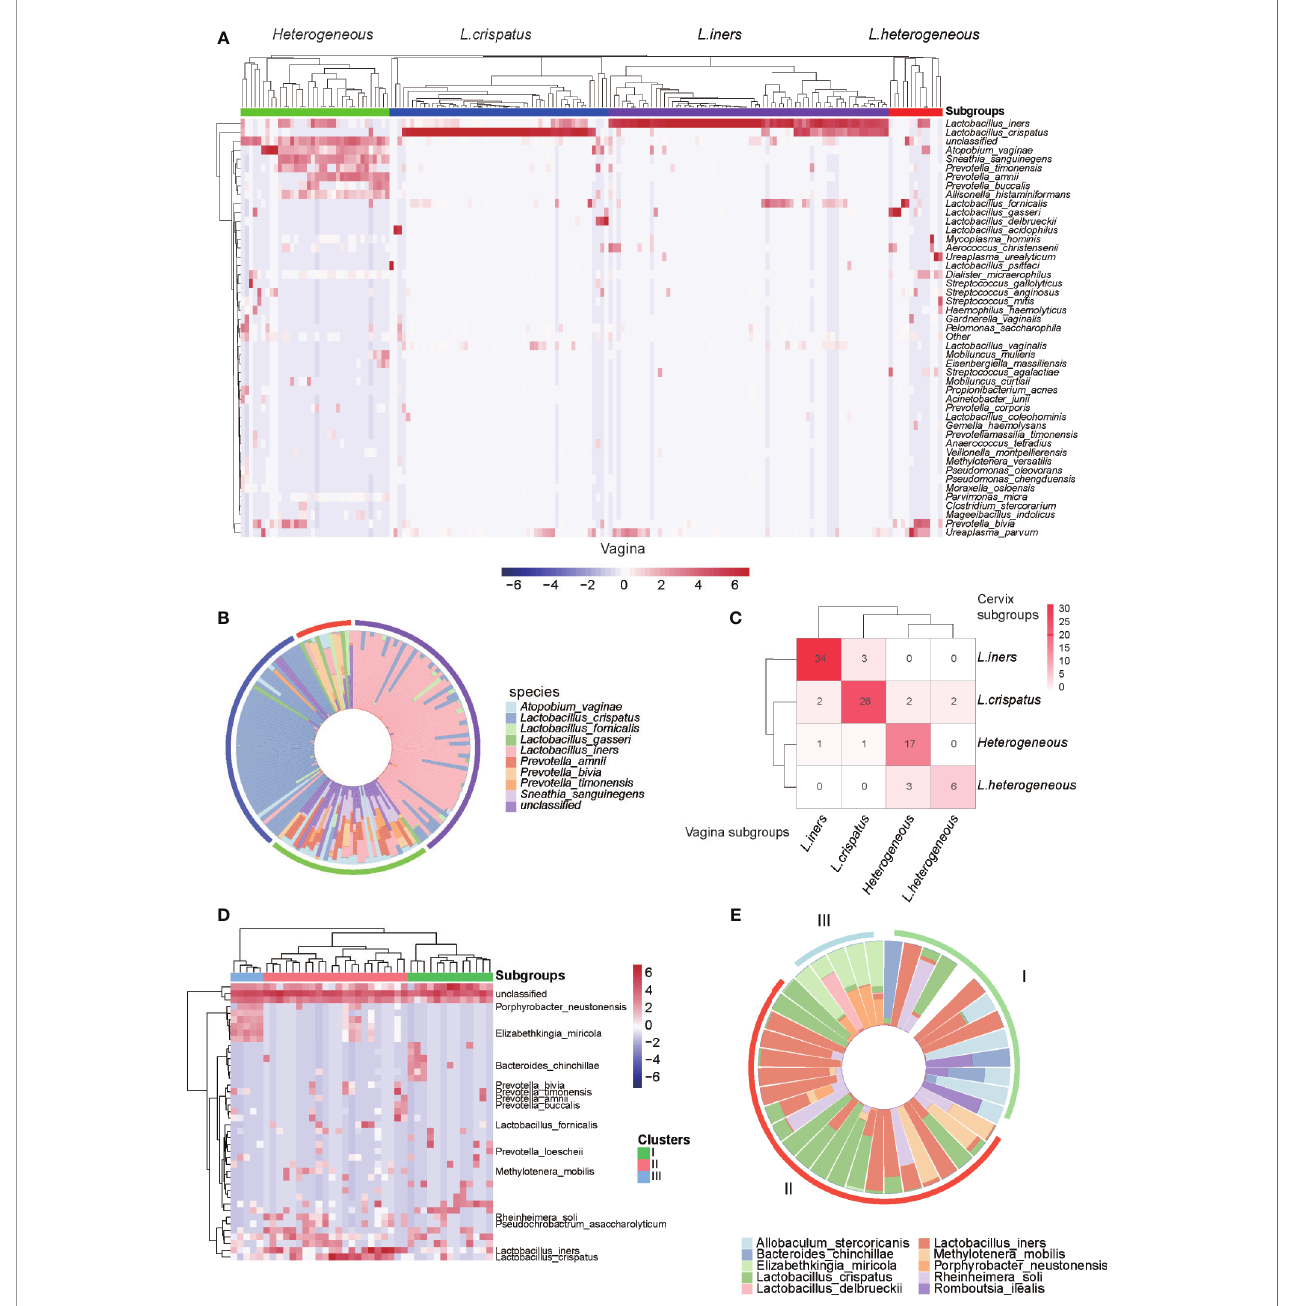
FIGURE 2 | Microbiome pro fi les of the reproductive-aged women. (A) Heatmap of log10-transformed relative abundance of species found in the vaginal bacterial communities. (B) Species-level vaginal microbiome composition in each vagitype (10 species with the highest mean relative abundance were selected). (C) “ Confusion matrix ” was used to evaluate concordance between groupings of the vagina and cervix. (D) Heatmap of the uterine bacterial communities. (E) Species-level vaginal microbiome composition in each uterine microbiota communities type (10 species with the highest mean relative abundance were